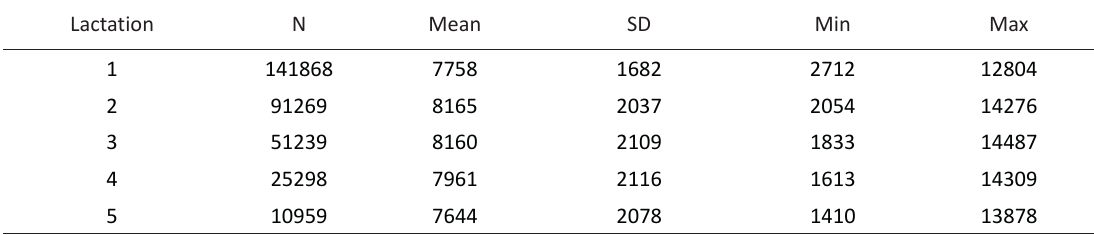
Table 5. Number of observations (N), mean, standard deviation (SD), minimum value (Min), and maximum value (Max) of the 305-d milk yield (kg)